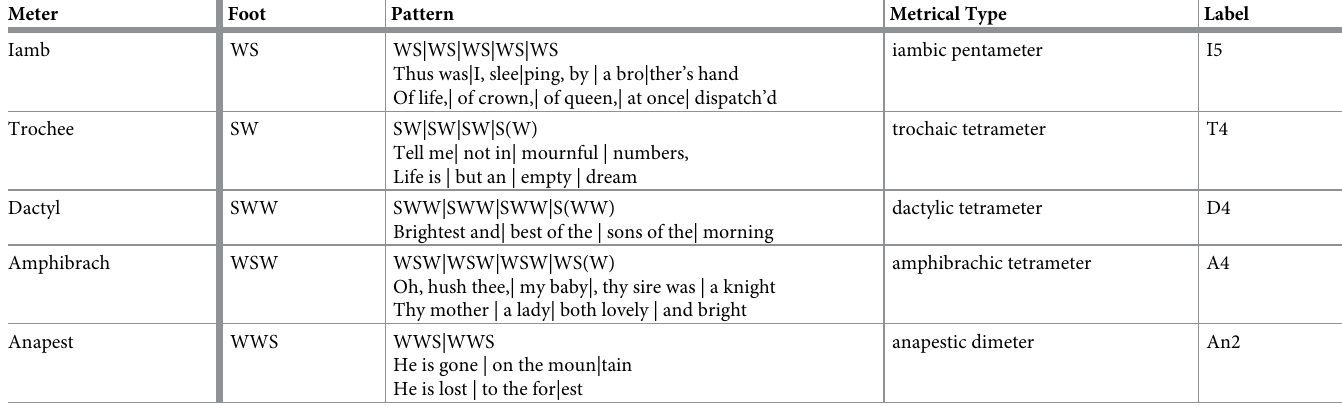
Table 1. Examples of accentual-syllabic metrical types and labeling strategies. S—denotes a strong position in the foot (stress expected), W—weak. Meter Foot Pattern Metrical Type